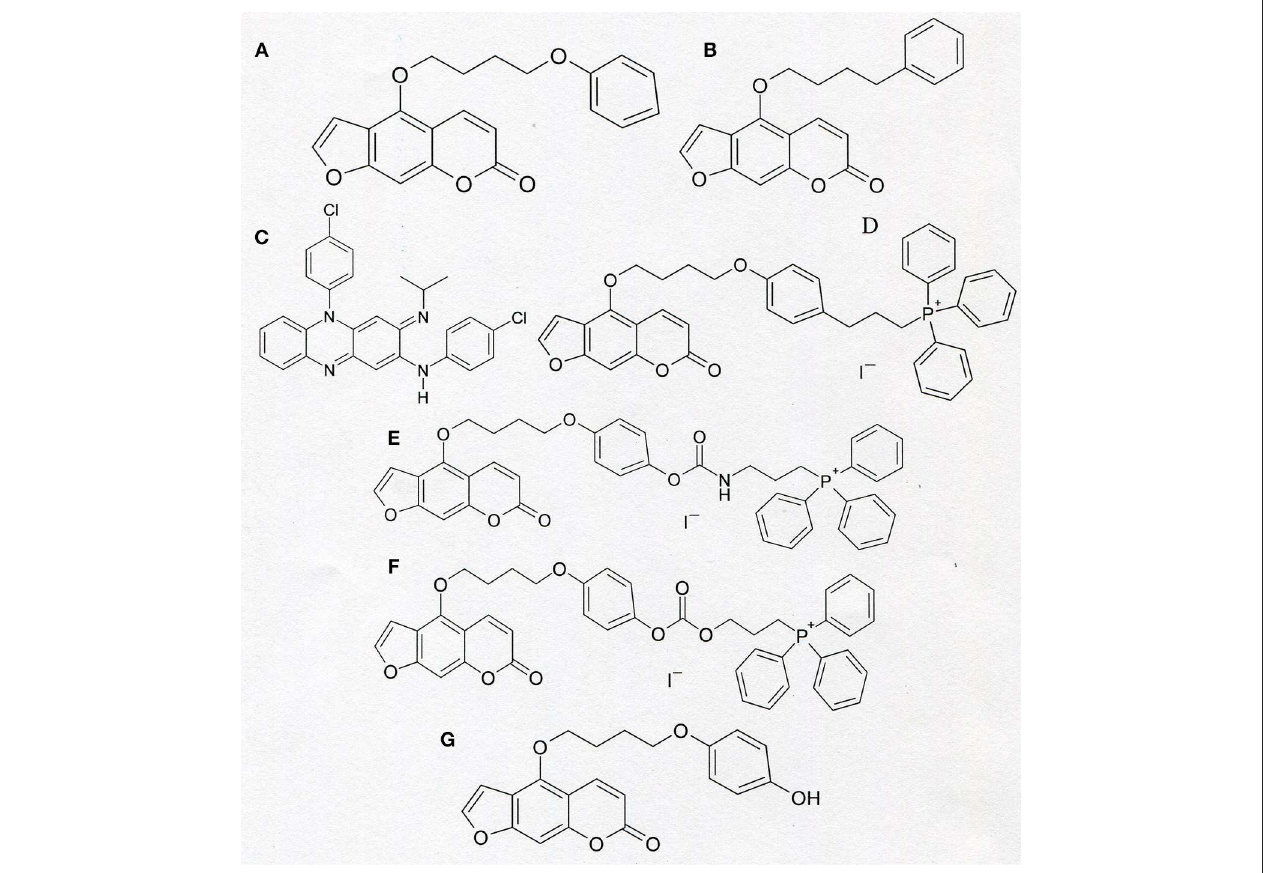
FIGURE 4 | Chemical structure of PAP-1 (A) , Psora-4 (B) , clofazimine (C) , and of “mitochondriotropic” compounds: PAPTP (D) , PCARBTP (E), and PCTP (F) . The formula of PAPOH—the product of hydrolysis of PCARBTP and PCTP is shown in the section (G)